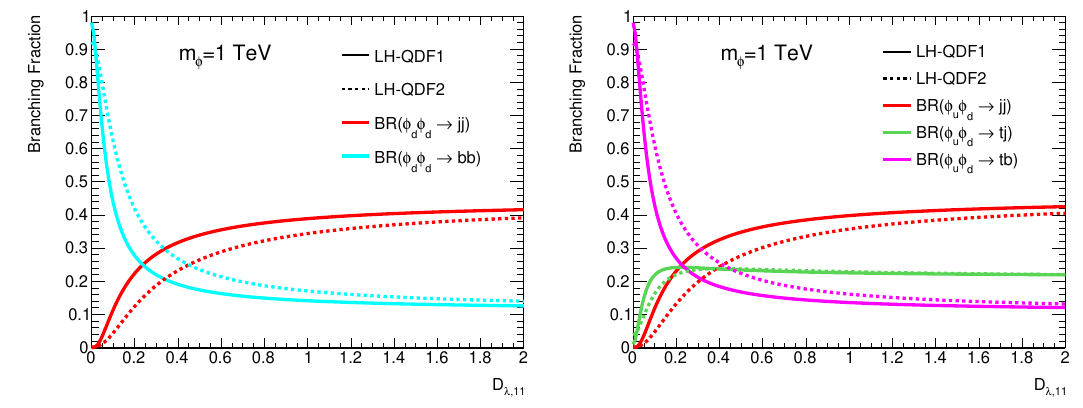
Figure 5 . Branching fractions for the allowed final states respectively for φ d φ d (left) and φ u φ d (right) production as a function of D . The solid (dashed) lines are for LH-QDF1 (LH-QDF2). λ, 11